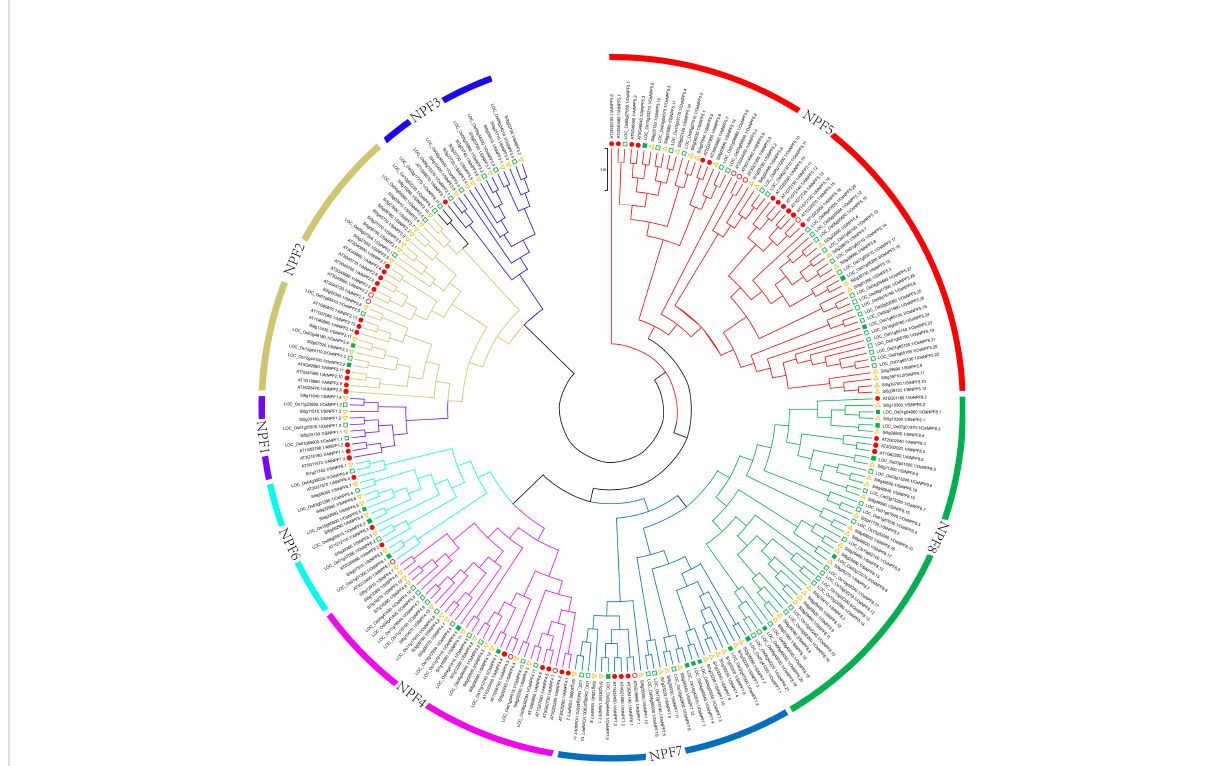
FIGURE 1 Phylogenetic relationship of NPF proteins among foxtail millet, rice and Arabidopsis. Different subfamilies are color-coded as illustrated in the fi gure. The red fi lled circle and the green fi lled square indicates these NPFs have been characterized in Arabidopsis (red fi lled circle) or rice (green fi lled square). The detailed information of these characterized NPF genes were summarized in Table S1.